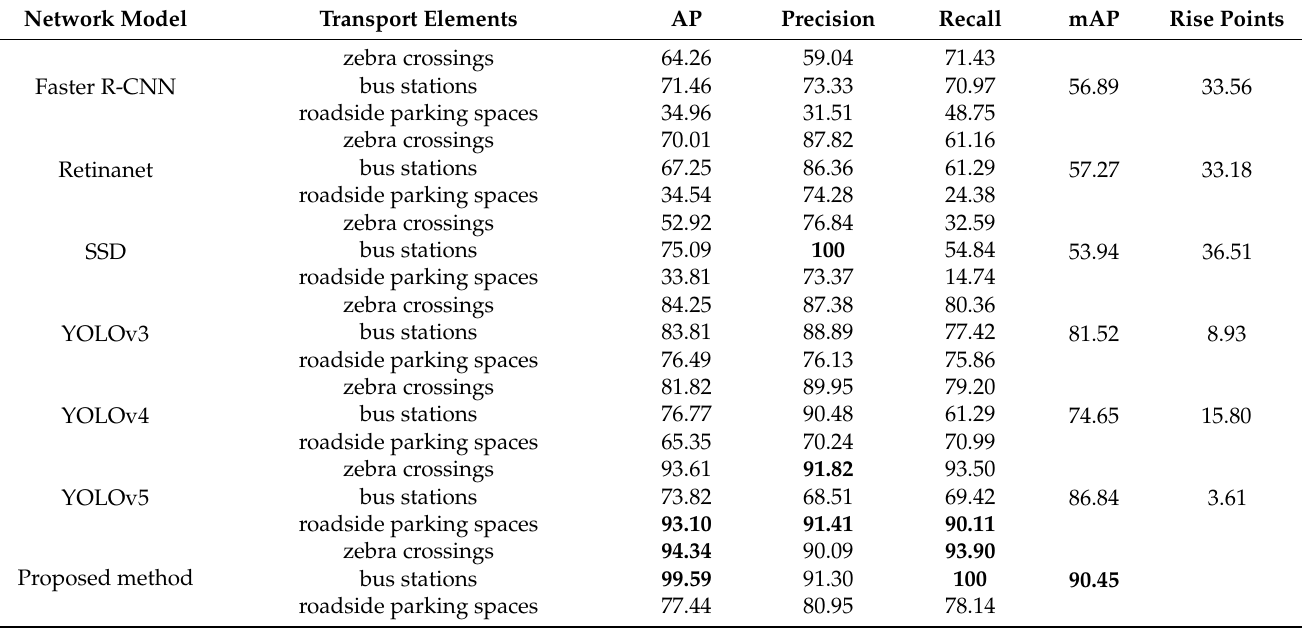
Table 2. Detection results of different